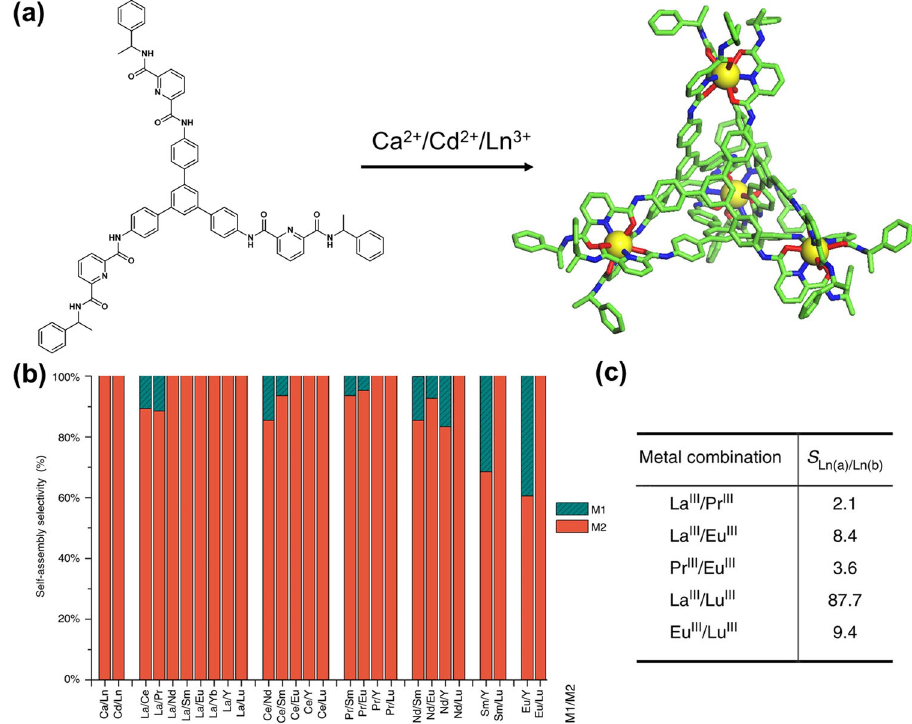
Fig. 2 Multivalent cooperative enhancement of metal ion selectivity. a Molecular structure of the tris-tridentate ligand ( L I ) and its self-assembled tetrahedral cage M 4 L 4 (M for metal ions). b Selective self-assembly of L I with M2 over M1 in the mixture of M1/M2 determined by 1 H NMR spectroscopy with ±5% error. c Separation factors (with ±5% error) from lanthanide solvent extraction experiment. Reproduced from ref. 17